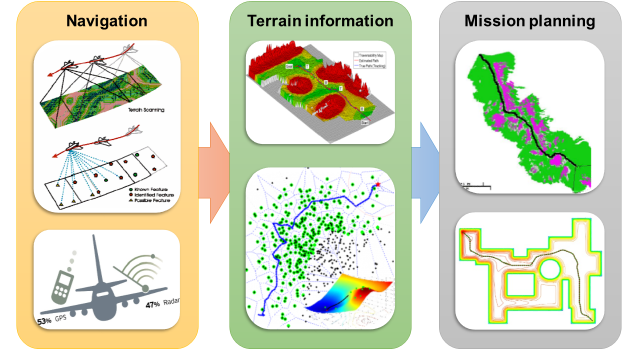
Figure 1. Role of navigation in UAV